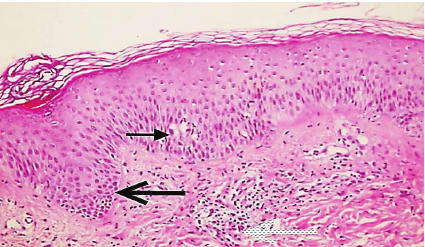
Figure 2: A photomicrograph of the biopsy showing neutrophilic pustular lesion together with epidermal spongiosis (thin arrow), minimal irregular acanthosis in epidermis (thick arrow), and neu- trophilicandeosinophilicinfiltrationarounddermalvessels(dashed arrow) (H&E × 200).